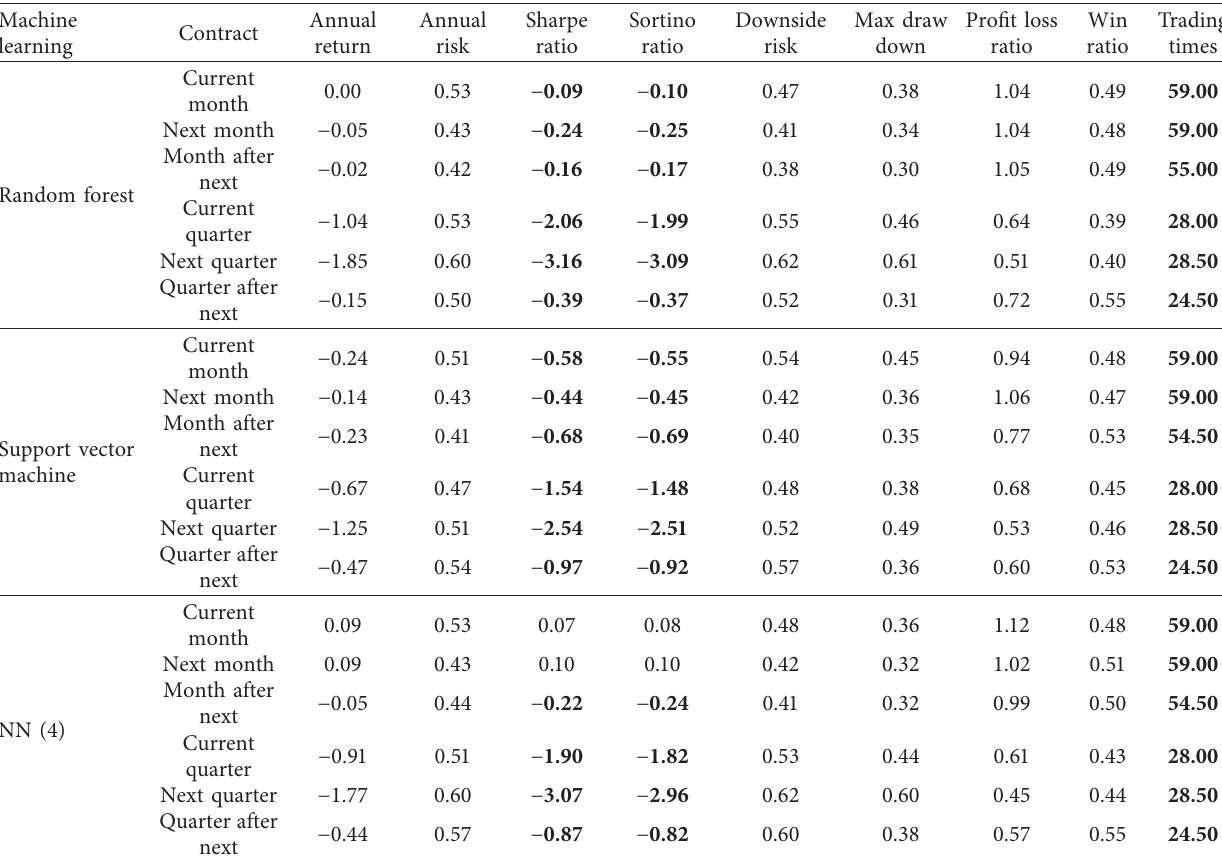
Table 4: Option strategy for directly predicting the rise and fall of volatility (use 12 features